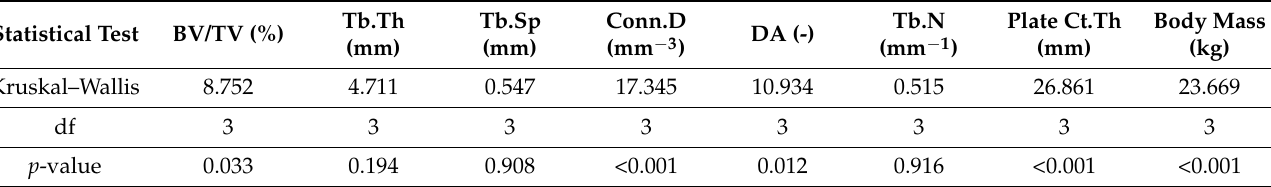
Table 5. Age category independent sample Kruskal–Wallis